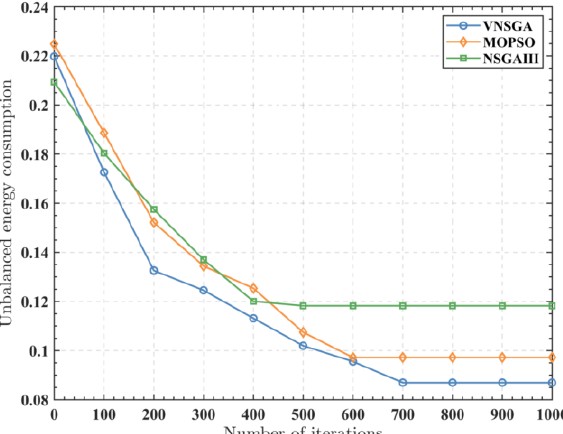
Figure 14. Unbalanced energy consumption for three algorithms from different iterations for 75 m R smax and 150 m R cmax with respect to area A.